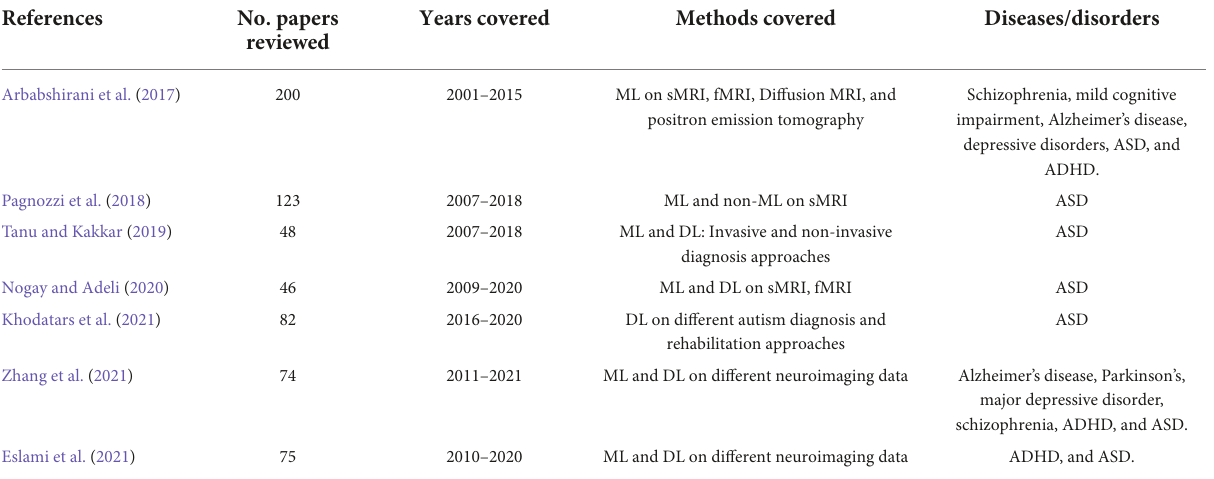
TABLE 1 ASD application review papers based on ML and DL methods with sMRI